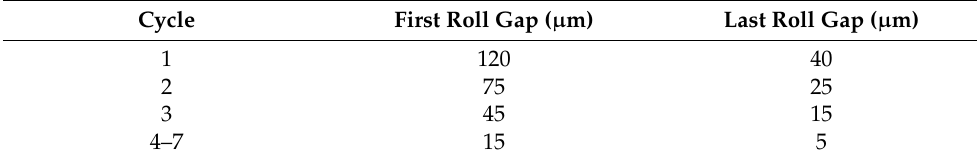
Table 1. Process conditions for three roll milling dispersion at room temperature. Cycle First Roll Gap ( µ m) Last Roll Gap ( µ m) 1 120 40 2 75 25 45 4–7 15